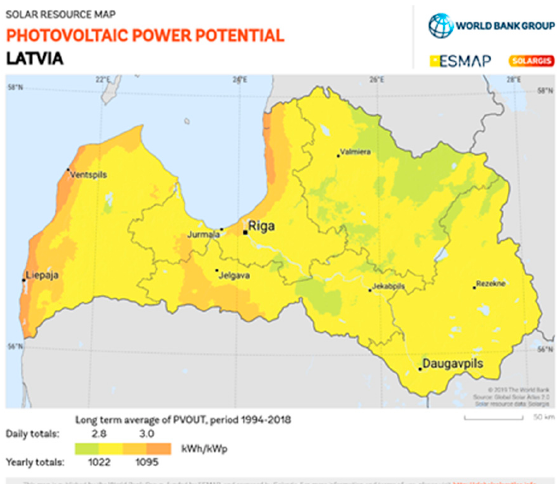
Figure 1. Photovoltaic (PV) power potential in Latvia [41].